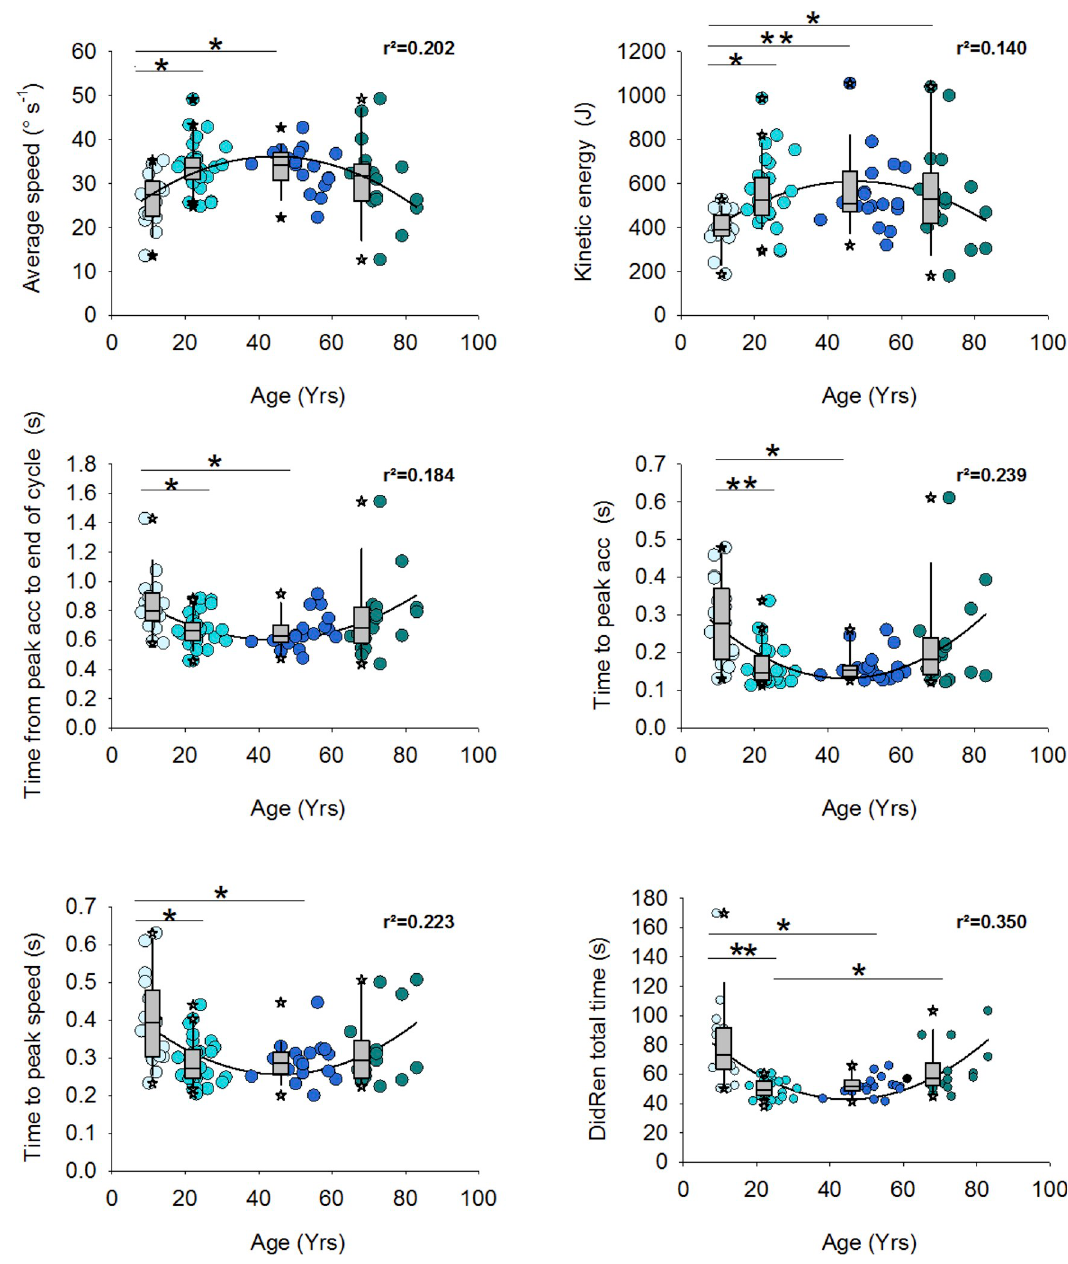
Fig 5. Box-plots and individual results for significant variables according to the different age-groups. Temporal performance (DidRen total time) and head-neck complex dynamics are represented as function of age and significant post hoc comparisons: � p < 0.05; �� p < 0.001. Second order polynomial regression curves (solid lines) were fitted across all data using the method of least